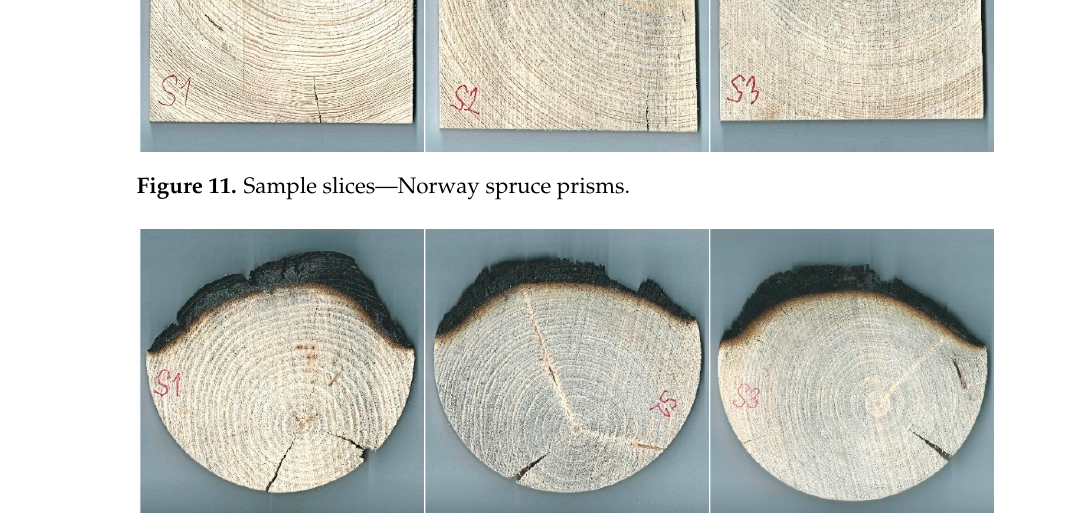
Figure 12. Sample slices—Norway spruce logs.